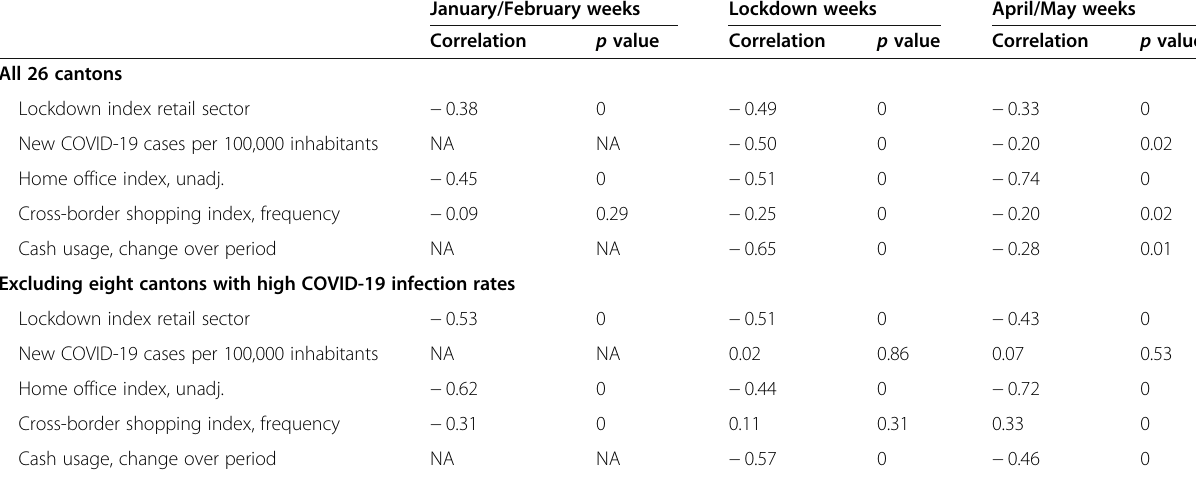
Table 1 Correlations of excess domestic card-present retail payments with selected indicators across the pre-lockdown, lockdown, and post-lockdown periods. Source: Own calculations, Worldline/SPS, SIX BBS AG,